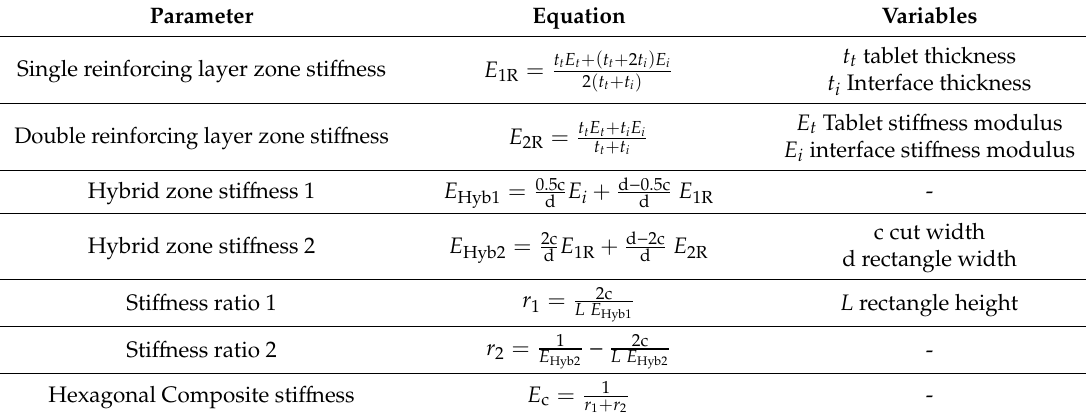
Table 4. Rectangular Composite Sti ff ness